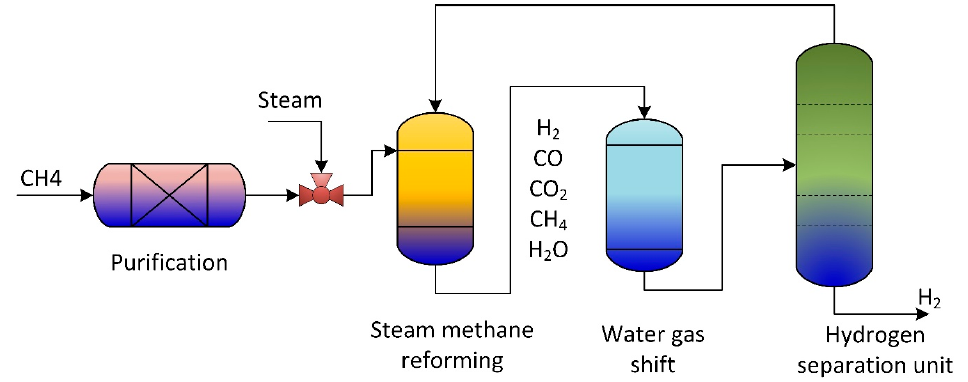
Figure 1. Schematic of traditional methane reforming unit for hydrogen production.